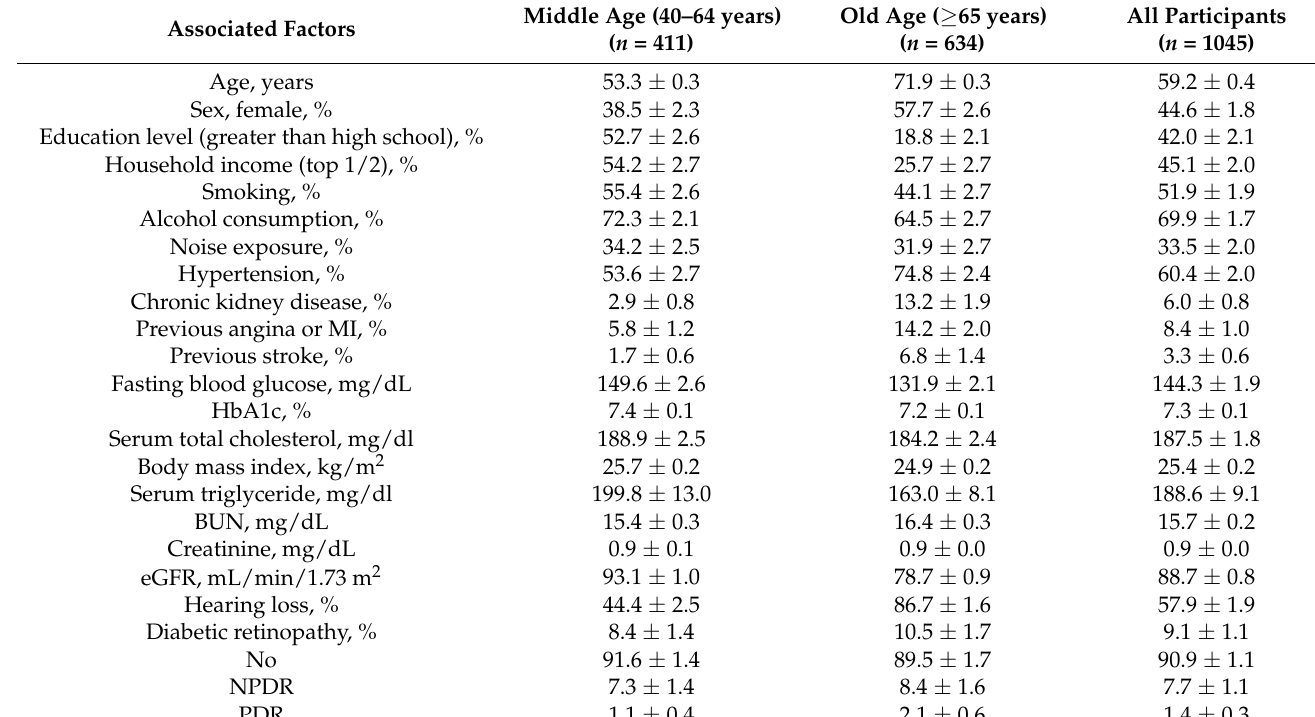
Table 1. Demographic and clinical characteristics of all participants and according to age